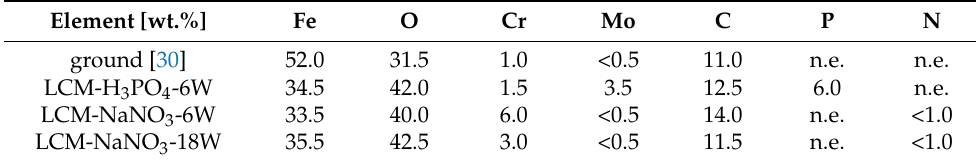
Table 3. Chemical composition of the uppermost rim zone prior to oxidation measured by XPS. Element [wt.%]